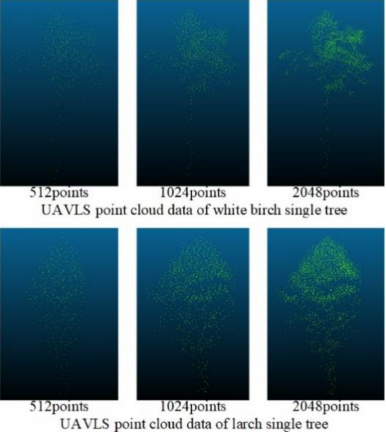
Figure 9. The sampling effect of the improved farthest point sampling method on Terrestrial Laser Scanning (TLS) data.